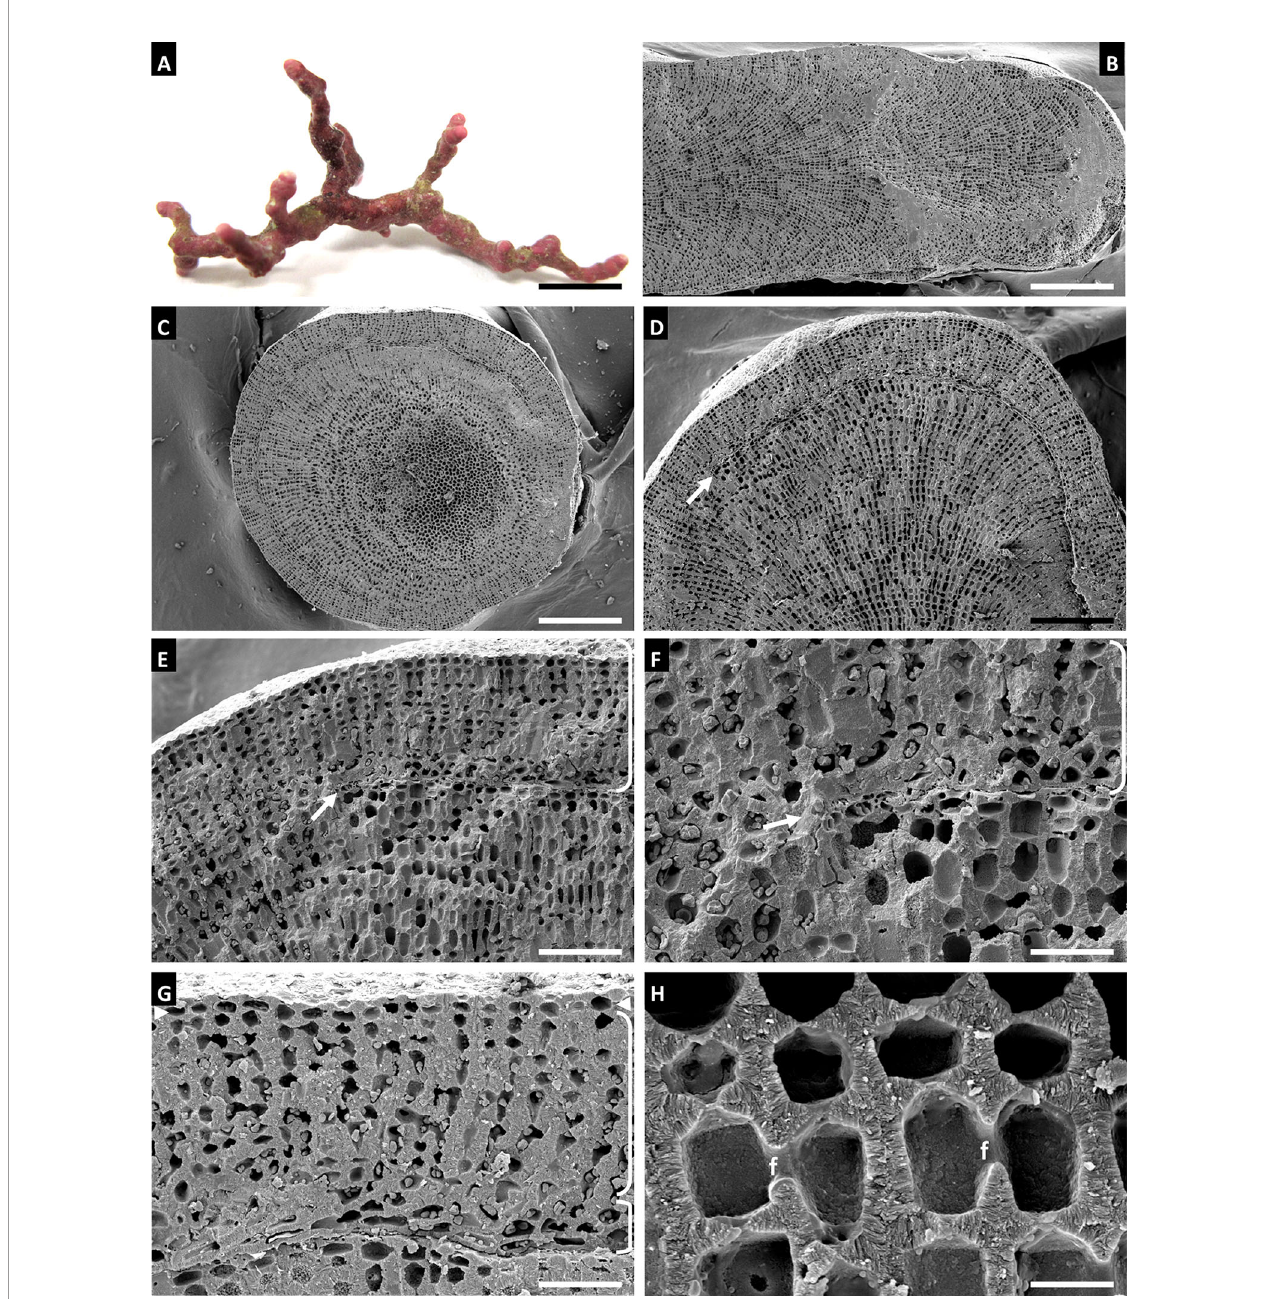
FIGURE 4 | Sporolithongracile Holotype, voucher no. LAF 7382 (A – H) . (A) Habit of holotype. Scalebar = 0.4 cm. (B) Longitudinal section of thallus protuberance showing radial construction. Scale bar = 350 µm. (C) Cross section of thallusprotuberance showing radialconstruction.Scalebar = 335 µm. (D) Longitudinal section showing origin of the new growth layer (arrow) over older portion ofthallus. Scalebar = 225 µm. (E, F) Magni fi edviews showing detailof new growth layer (arrow,bracket) over older portion of thallus. Scale bars= 90, 35 µm. (G) Detailof new growth layer showing secondary hypothalluswith monomerousconstruction (lower bracket),perithallus (upper bracket), andintercalary meristem (arrowheads) over older thallus layer.Scalebar = 45 µm. (H) Perithallus with cell fusions(f).Scalebar = 11